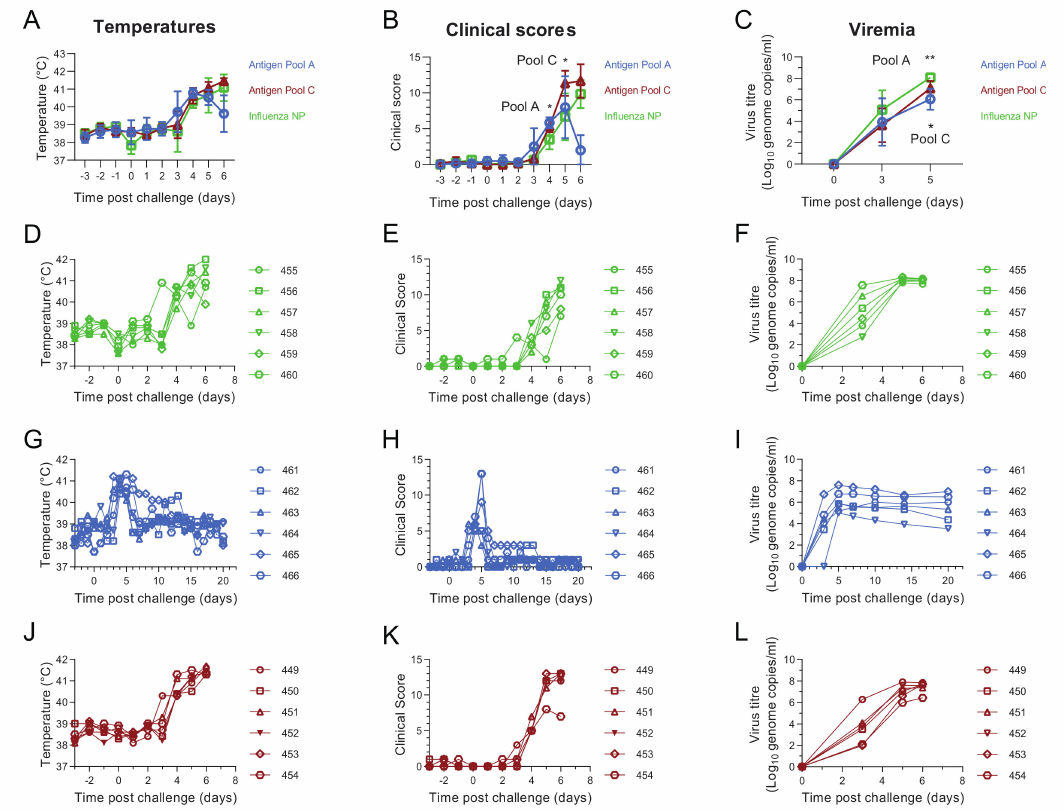
Figure 7. Clinical and virological parameters in experiment 2. Mean temperatures ( A ), clinical scores ( B ) up to six days and viremia up to five days post-challenge ( C ) of groups of six pigs primed and boosted with Antigen Pool A (blue), Antigen Pool C (red) or influenza NP (green). Temperatures ( D , G , J ) and clinical scores ( E , H , K ) for each individual pig immunized with influenza NP ( D , E ), Antigen Pool A ( G , H ) or Antigen Pool C ( J , K ) are shown. Blood was taken from animals immunized with Influenza NP ( F ), Antigen Pool A ( I ), Antigen Pool C ( L ) on the indicated days and DNA was extracted in duplicate and the viral titer determined by qPCR, with each extraction tested in duplicate. Data points are the mean of the duplicate extractions. Errors bars on panels A, B and C indicate standard deviation from the mean. Black asterisks on panels B and C show significant di ff erences (repeated measures two-way ANOVA) of the indicated group of pigs compared to the control, * p ≤ 0.05 or ** p ≤ 0.01. Red asterisks on panels A and B show significant di ff erences (repeated measures two-way ANOVA) between pigs immunized with Antigen Pools A and B six days post-infection, * p ≤ 0.05 or **** p ≤